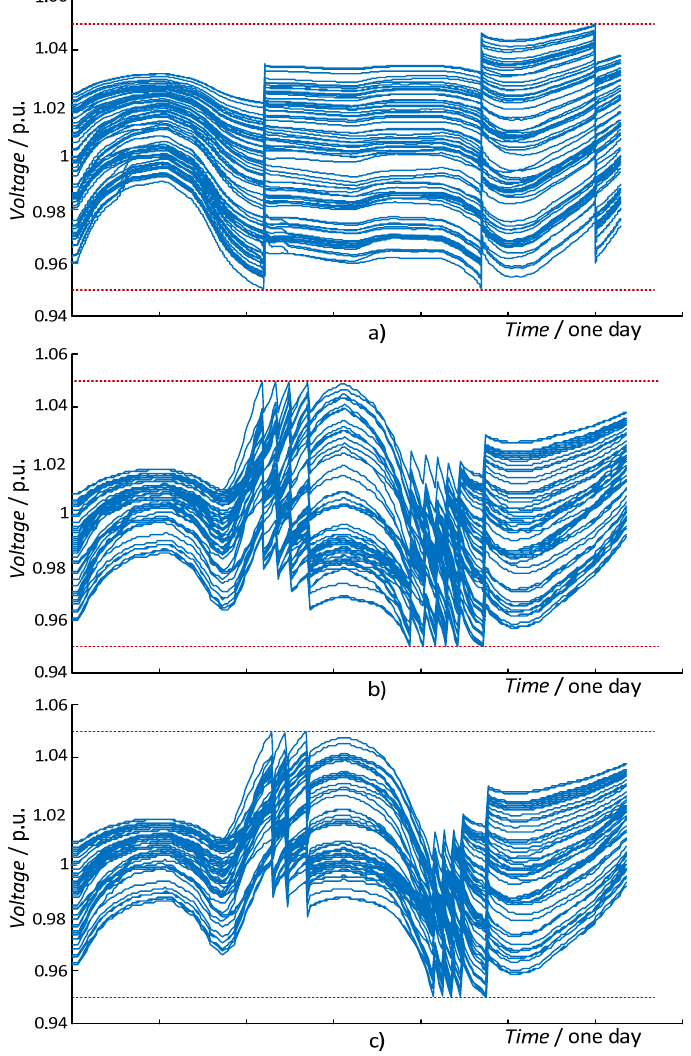
Figure 10. One day voltage profile of MV/LV substations measured at the critical areas around the distribution system. ( a ) Voltage profile before the introduction of DG; ( b ) voltage profile with DG working with cos φ = 1; ( c ) voltage profile using static Q ( U )